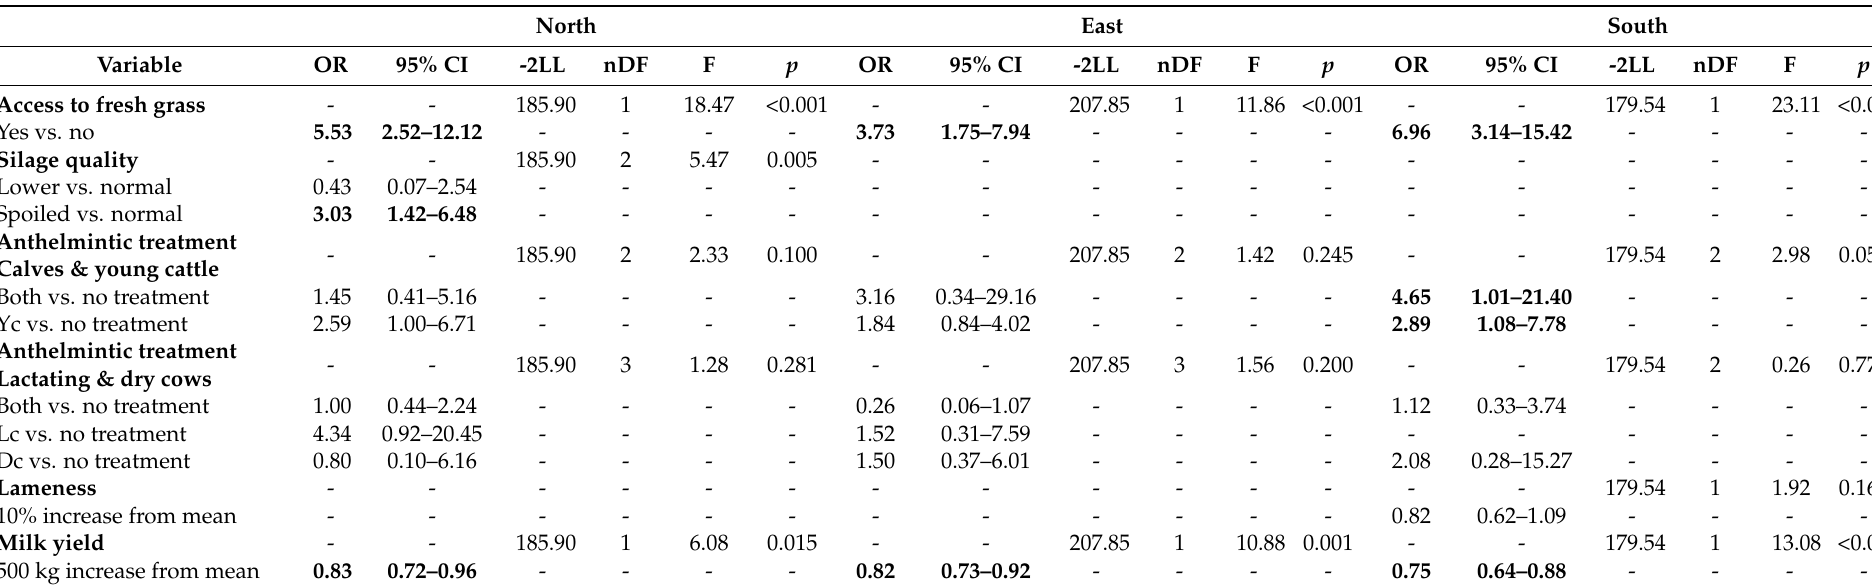
Table 3. Results from multivariate logistic models investigating the influence of predictor variables on O. ostertagi BTM ELISA results (North: Df = 172; East: Df = 183; South: Df = 190). Significant ORs and CIs are printed in bold.